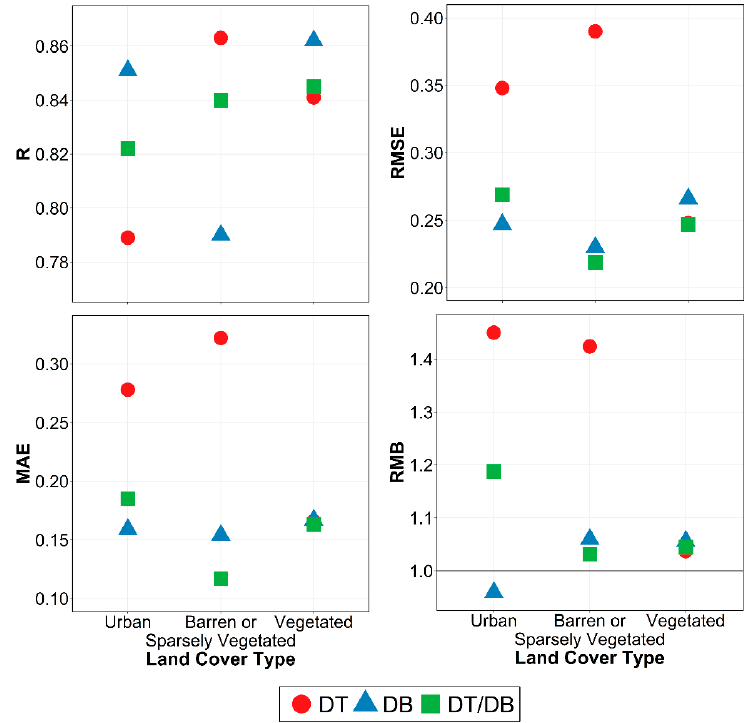
Figure 7. Error statistics for DT, DB, and DT/DB products against AERONET AOD ground-observed measurements over different land cover types.